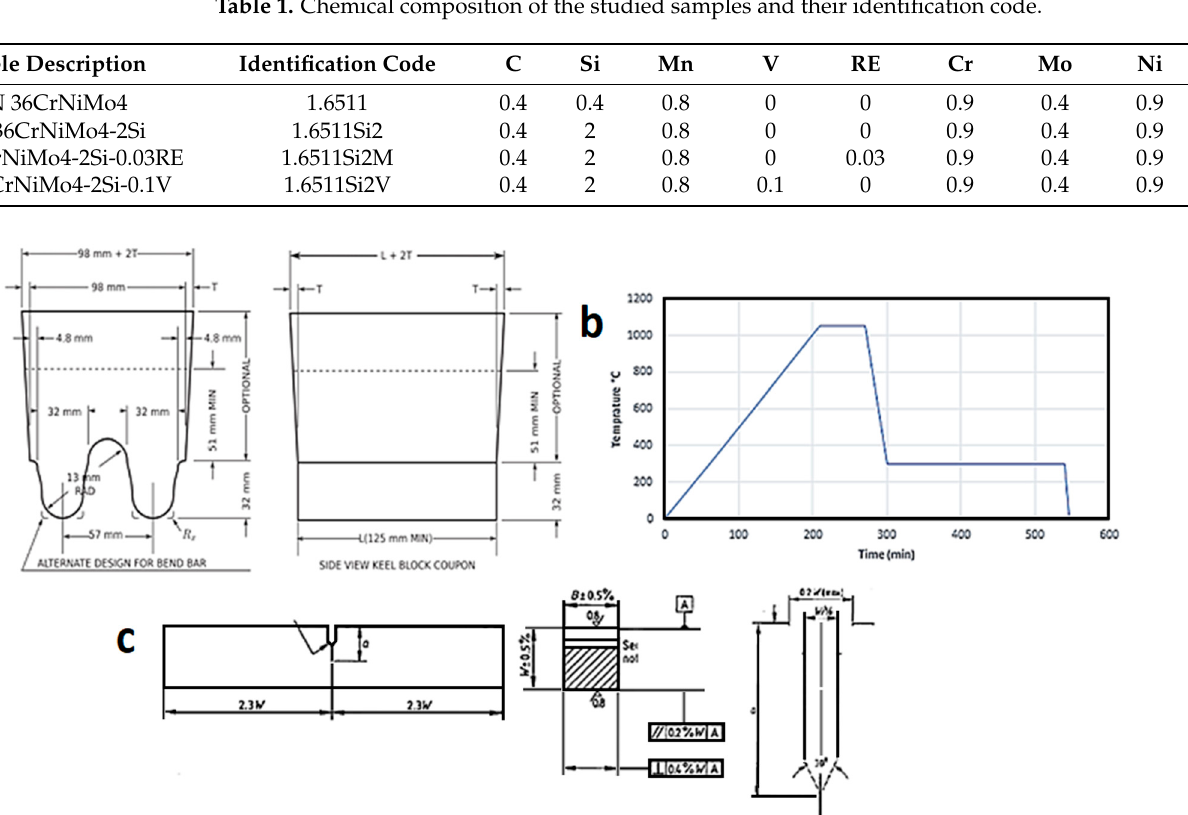
Table 1. Chemical composition of the studied samples and their identification code.